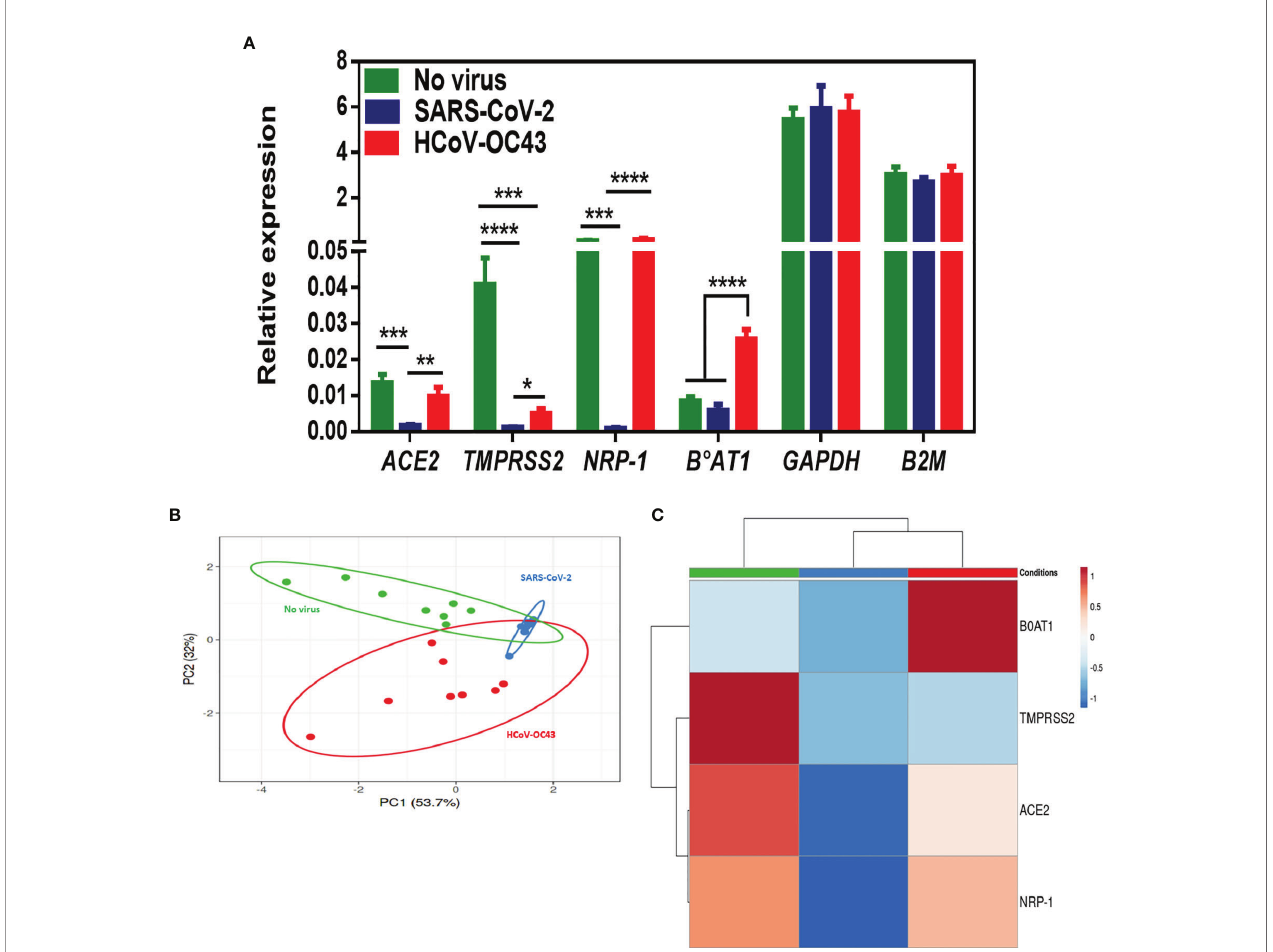
FIGURE 4 | (A) mRNA expression of ACE2, TMPRSS2, NRP-1, B 0 AT1, GAPDH, and B2M in virus-free Caco-2 cells or cells exposed to coronaviruses SARS-CoV- 2 or HCoV-OC43 at a MOI of 0.5 for 24 hours. The results (n=8) are expressed as RE where RE = 2 ( − D CT) . (B, C) PCA and hierarchical clustering heatmap analysis of different molecules expressed on Caco-2 cells in virus-free cells, and cells exposed to coronaviruses SARS-CoV-2 or HCoV-43. The symbol *** means a p-value < 0.001; the symbol **** means a p-value <